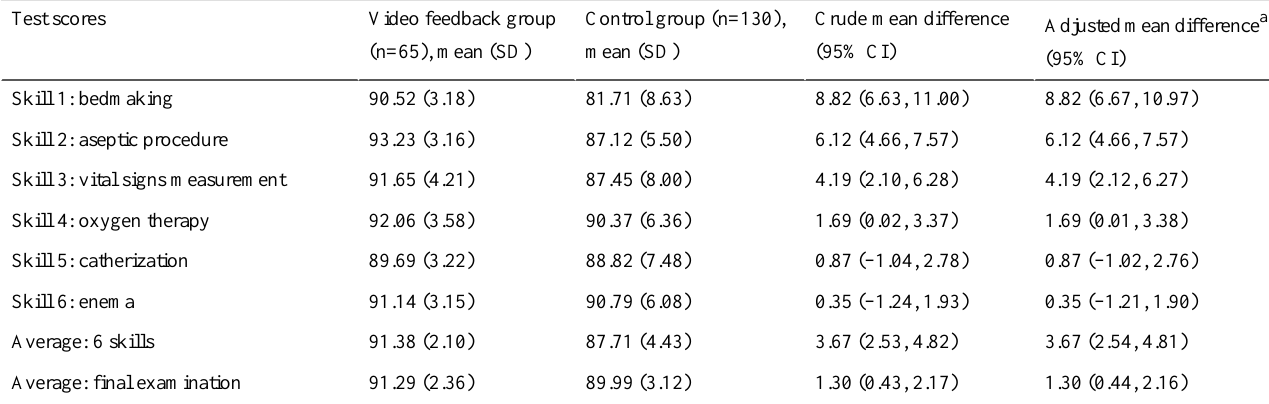
Table 2. Comparison of scores in the 6 nursing skills between the intervention and control